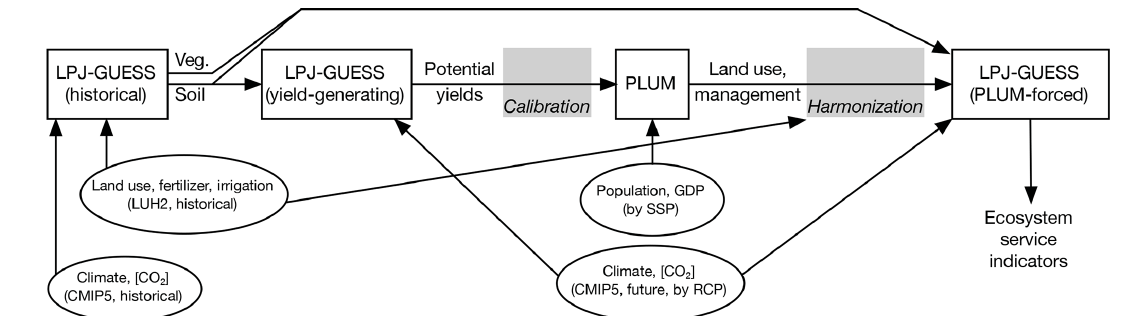
Figure 1. LandSyMM structural overview. Ovals represent external input data and white rectangles represent model runs, with arrows indicating data flow from one model run to the next. Gray rectangles represent model coupling processes whose external inputs have been excluded for simplicity; more information on these can be found in the